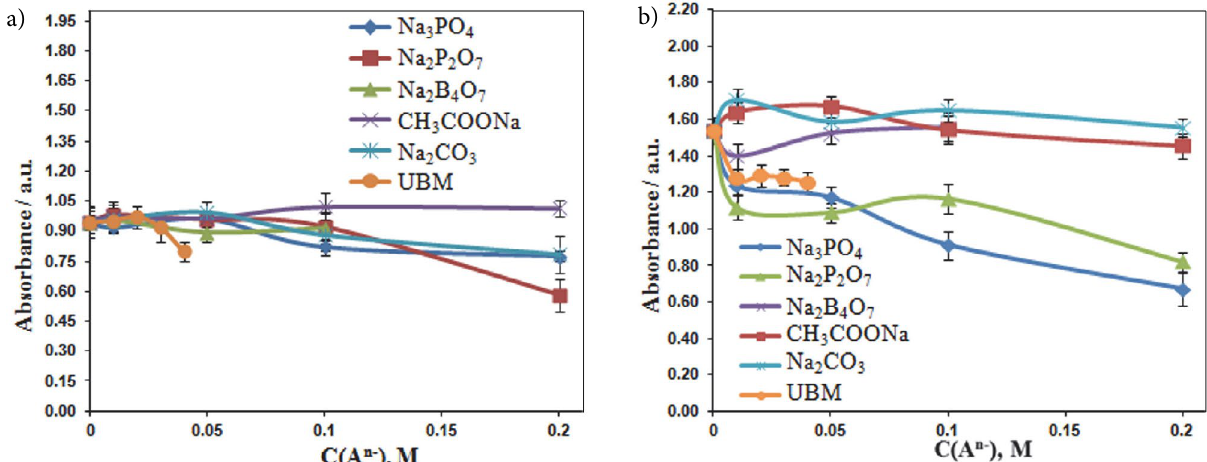
Fig. 6. Influence of nature and concentration of salts anions (acetate, pyrophosphate, carbonate, tetraborate, phosphate) and buffer solution (UBM) on the a) SA and b) STZ interaction with AM. 1. C SA = 2.0 . 10 –4 M, C HCl = 0.6 M; 2. C STZ = 2.0 . 10 –4 M, C HCl = 0.7 M; C NaNO 5.0 . 10 –5 M, n =